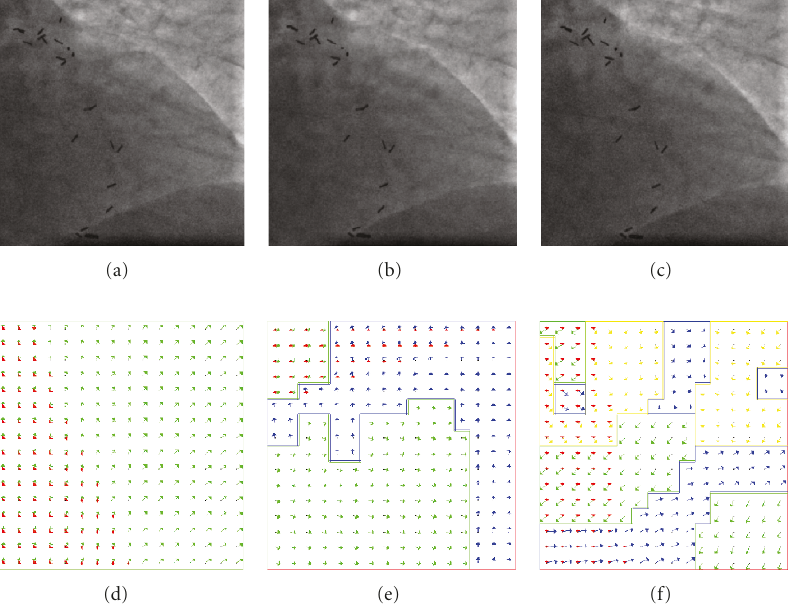
Figure 8: Example of a X-ray interventional cardiac image sequence, (a)–(c): image acquired at three di ff erent time instants, (d), (e), (f): the corresponding velocity fields supplied by the estimated a ffi ne motion models, plotted in di ff erent colours according to the segmented layer they are belonging to. (a) presents an example of global bitransparency; (b) illustrates the ability of the method to handle dominant motions in case of three simultaneous transparent layers in some areas; (c) refers to a complex configuration in which a trade-o ff has to be met between accurate motion estimates and clean segmentation